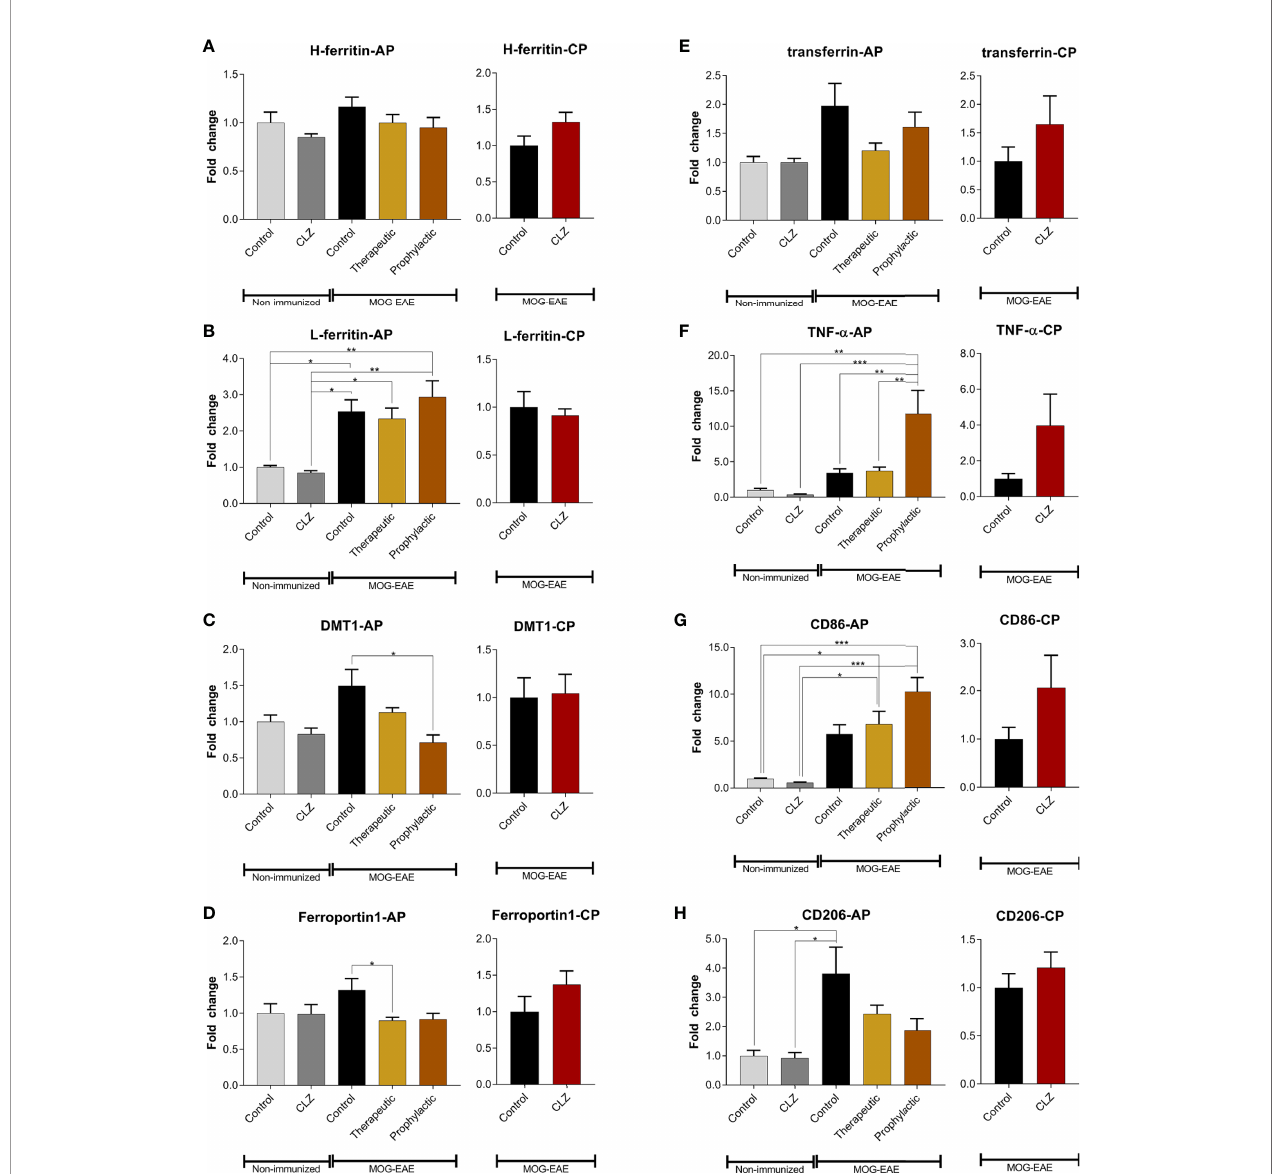
FIGURE 6 | Clozapine administration alters iron metabolism of the spinal cord. (A) While H-ferritin was not affected, (B) L-ferritin was upregulated in EAE mice (p < 0.05) but not altered following clozapine administration. (C) DMT-1 was downregulated following prophylactic clozapine administration compared to untreated EAE mice (p < 0.05). (D) Ferroportin-1 was downregulated following therapeutic treatment with clozapine (p < 0.05). (E) Transferrin was not affected. (F) Prophylactic clozapine administration led to signi fi cant upregulation of TNF- a compared to non-immunized mice or therapeutic treatment (p < 0.01). (G) CD86 was signi fi cantly upregulated compared to non-immunized mice (p < 0.05), but lacked signi fi cance compared to EAE mice. (H) CD206 was upregulated in vehicle EAE mice, clozapine had no effect. Non-immunized groups n = 3 each, acute phase treatment groups n = 6 each (prophylactic administration n = 5) and chronic phase treatment groups n = 6 each. Data were normalized to non-immunized and untreated mice for acute phase treatment and to vehicle group for chronic phase treatment. Tbp and Hprt1 were used as housekeeping genes. Data are shown as mean ± SEM. One-way ANOVA with Tukey ’ s multiple comparison as post hoc analysis (AP) and two tailed unpaired t-test (CP) were used for analysis. Signi fi cances are depicted as *p < 0.05, **p < 0.01 ***p <